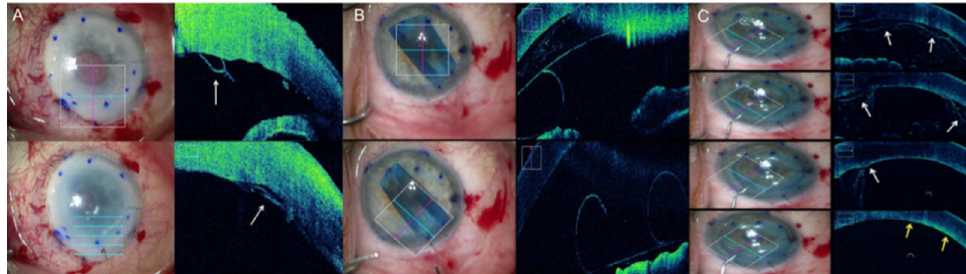
Figure 3. Microscope-integrated optical coherence tomography (MI-OCT) assisted Descemet’s membrane endothelial keratoplasty (DMEK). ( A ) The left column shows en-face view. The right column shows the accompanying MI-OCT image. Top row: Peripheral Descemet’s membrane remnants prior to graft insertion (arrow). Bottom row: Attached graft overlapping Descemet’s membrane remnants (arrow). ( B ) Top row: Inverted graft after insertion. Bottom row: Corrected graft orientation. ( C ) From the top to bottom, rows represent consecutive time points. Progressive graft apposition during gas infusion (fluid interface indicated by white arrows; complete graft apposition indicated by yellow arrows).